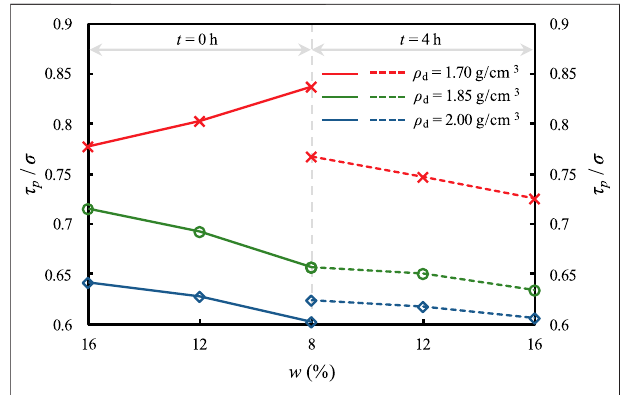
FIGURE 7 | Effect of dry density and water content on shear strength under different thawing